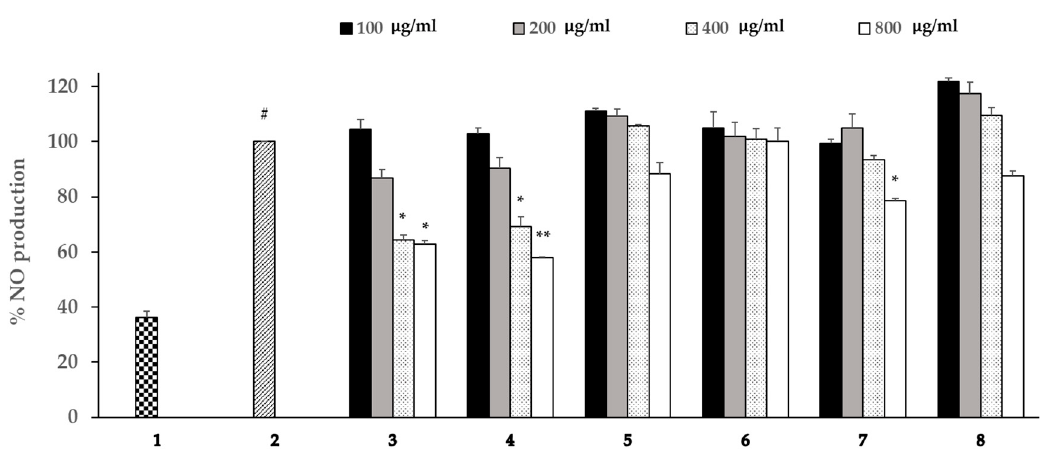
Figure 1. E ff ects of the extracts on the production of NO in LPS-stimulated RAW 264.7 macrophages. Cells were pretreated with various concentrations (0–800 µ g / mL) of each extract for 1 h and then stimulated with LPS (1 µ g / mL) for 18 h. NO production was determined using Griess reagent. 1, control; 2, LPS treatment; 3, P. granatum ; 4, P. guajava ; 5, C. arborea ; 6, G. decora ; 7, S. obtusa ; 8, F. hispida . The data illustrates the mean of three independent experiments, each performed in triplicate (n = 3). Error bars indicate SD. (Significant versus the non-treated control, # p < 0.001; significant versus LPS treatment, * p < 0.05, ** p < 0.01)